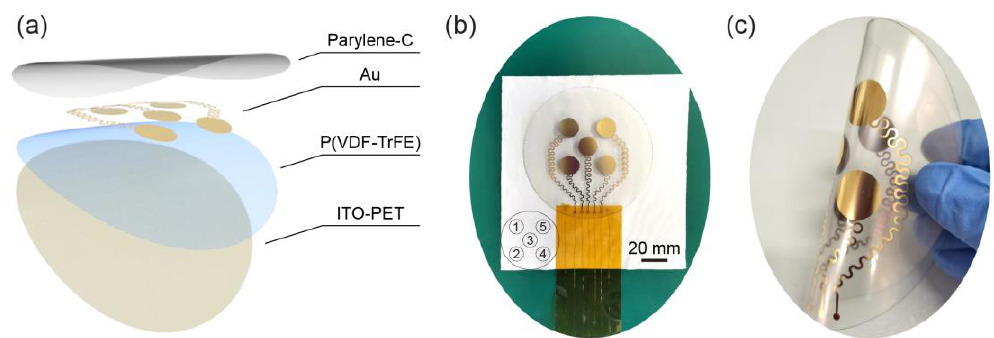
Figure 1. ( a ) Schematics of the cross-shaped sensor array. ( b ) Photograph of the fabricated crossed-shaped P(VDF-TrFE) based sensor array with a shared bottom electrode, where the inset describes the labels of the five sensor units. ( c ) Photograph of the flexibility of the sensor array.